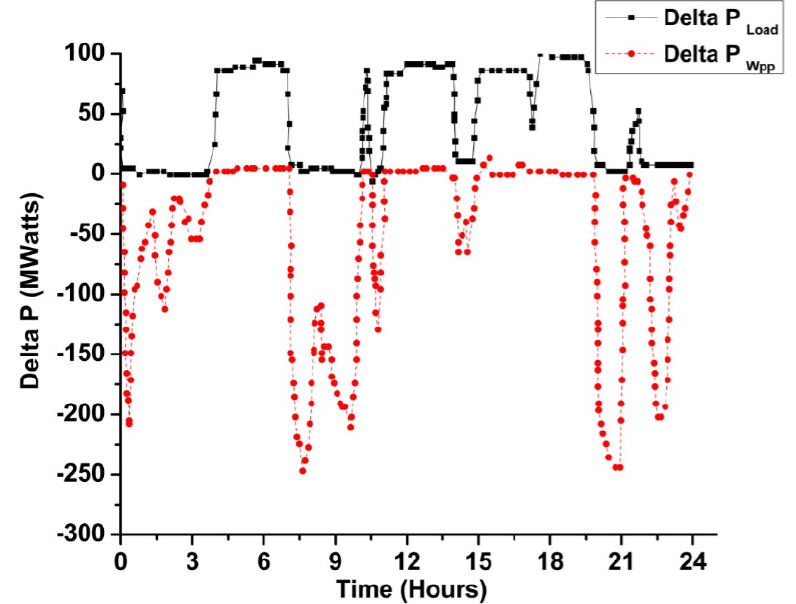
Figure 11. Secondary dispatch strategy for WPPs, CHPs and flexible